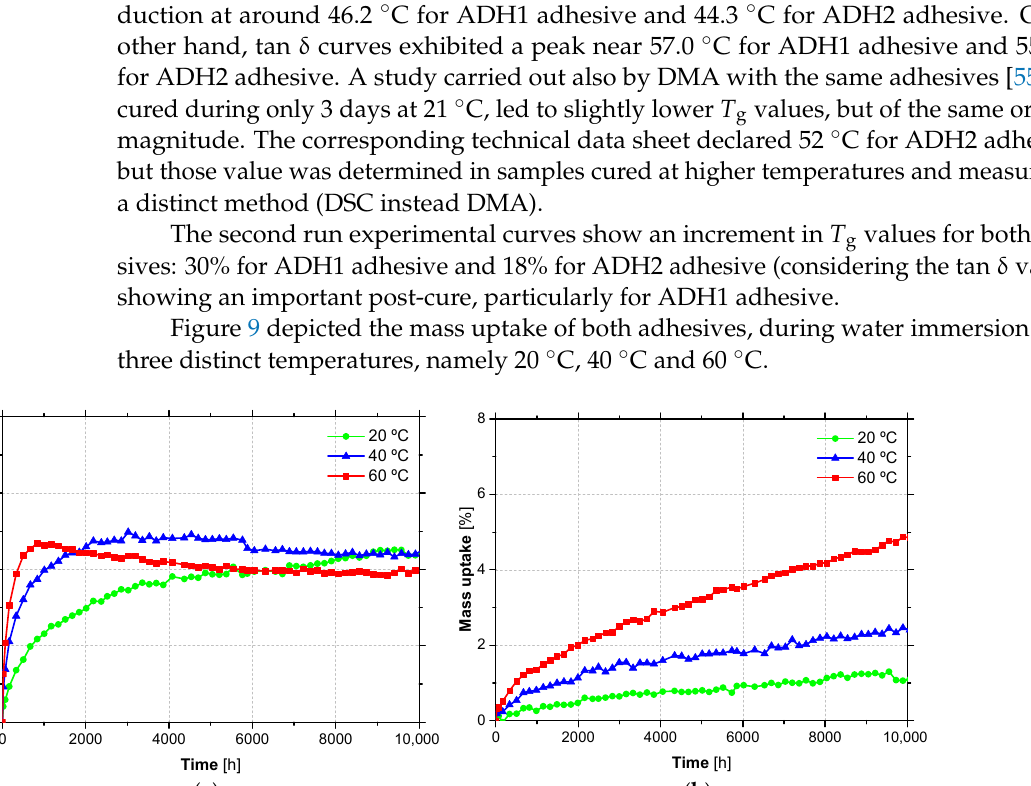
Figure 9. Water absorption of adhesives ( a ) ADH1 and ( b ) ADH2 at 20 °C, 40 °C and 60 °C.